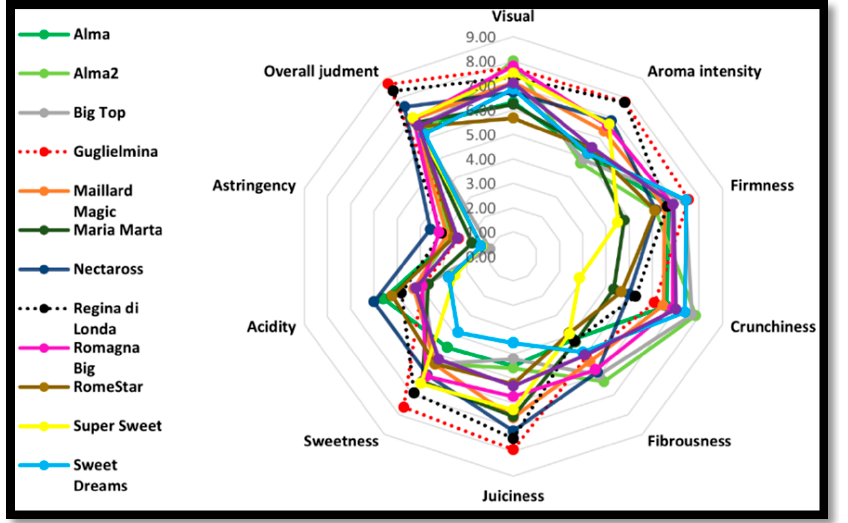
Figure 3. Schematic representation of the average values of the scores of ten attributes used for the sensory analysis. sensory